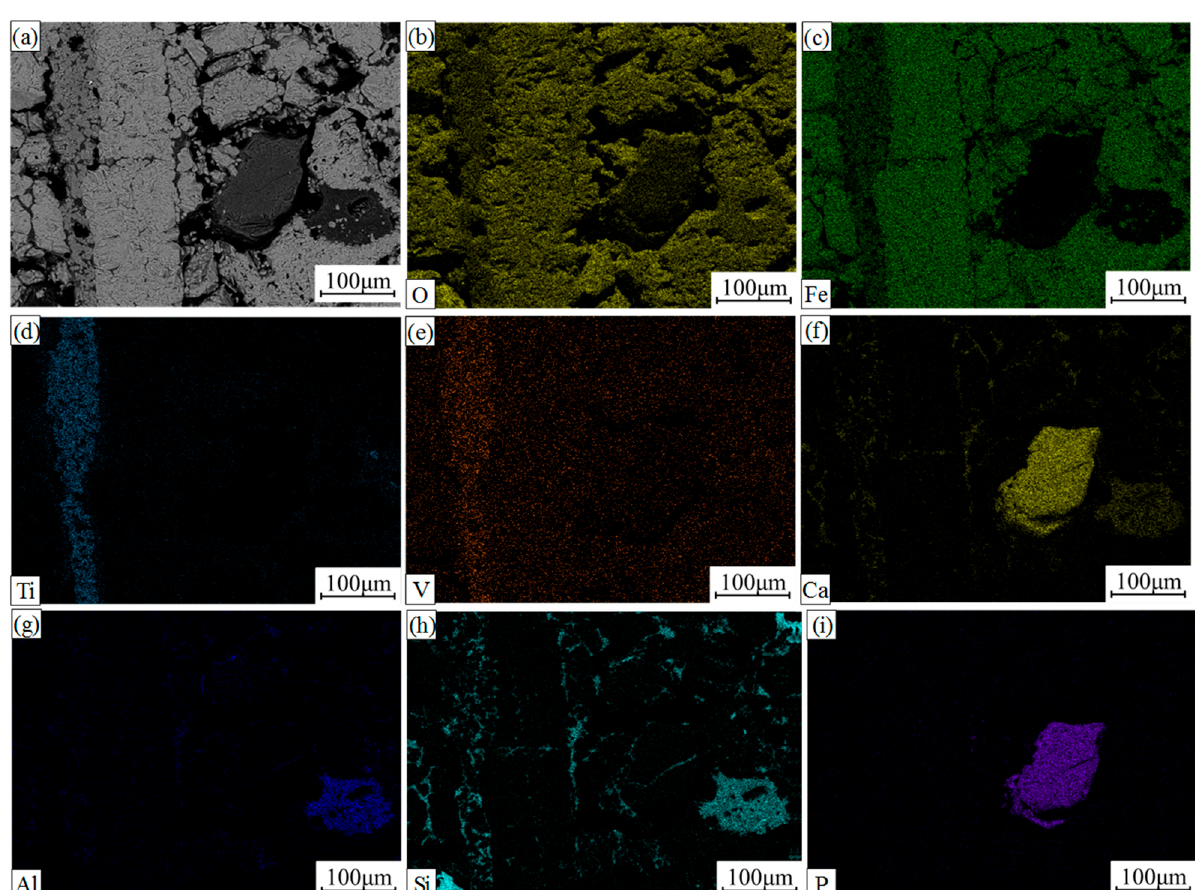
Figure 11. Element distributions of the oxidized pellets with 40% sea sand ore. ( a ) Electronic image; ( b ) O; ( c ) Fe; ( d ) Ti; ( e ) V; ( f ) Ca; ( g ) Al; ( h ) Si; ( i ) P.